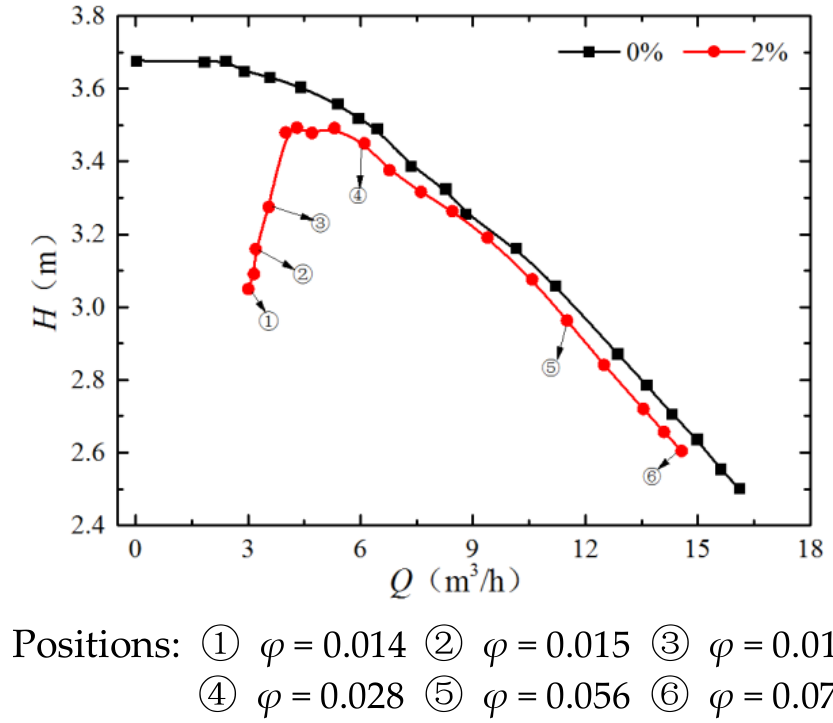
Figure 6. Pump performance head coefficient versus flow coefficient for α = 0% and 2%.